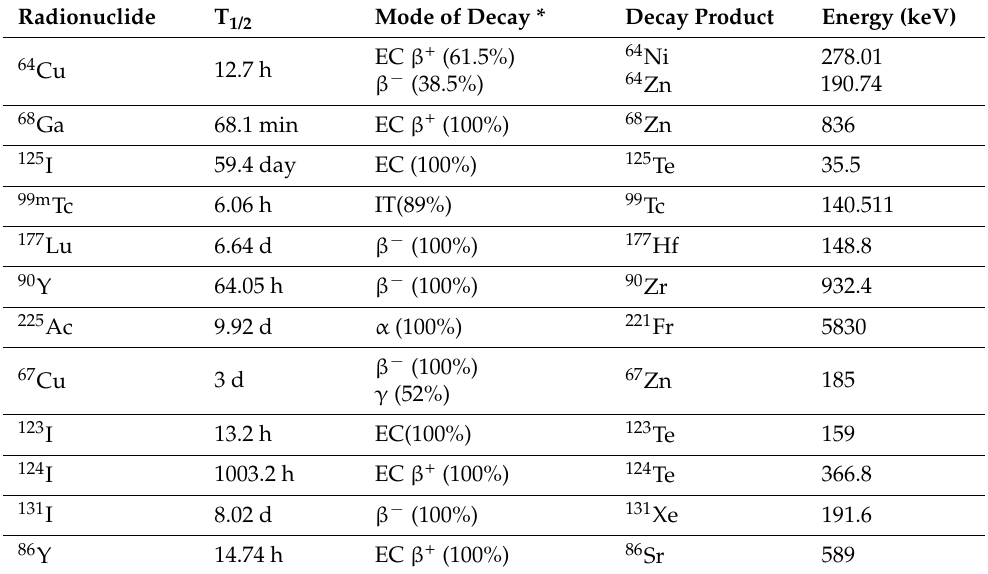
Table 1. Physical properties of commonly used imaging (PET/SPECT) radionuclides discussed in this